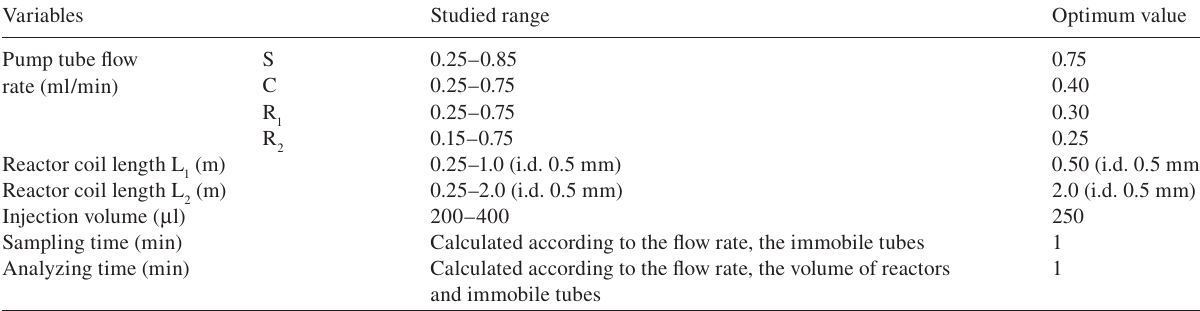
Table 1 Optimization of rFIA variables.